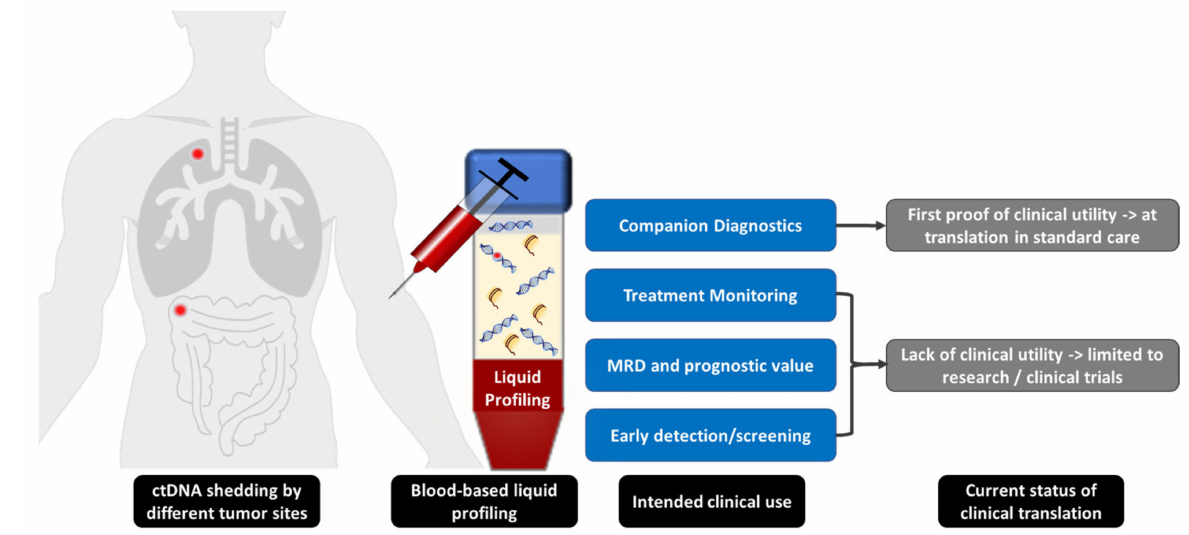
Figure 1. Clinical applications of liquid